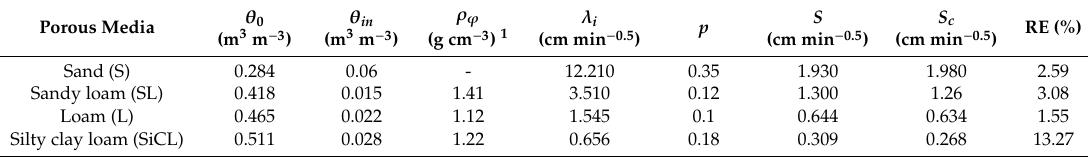
Table 1. The values of the soil characteristics θ 0 , θ in , ρ ϕ , and S , together with the values of the parameters λ i , p , and S c for each soil examined. The value of the parameter p was estimated from Equation (6). The value of sorptivity S was obtained directly from the experimental I ( t ) data (Equation (18)), while S c comes from Equation (14). RE denotes the absolute relative error between actual S and estimated S c values for each soil